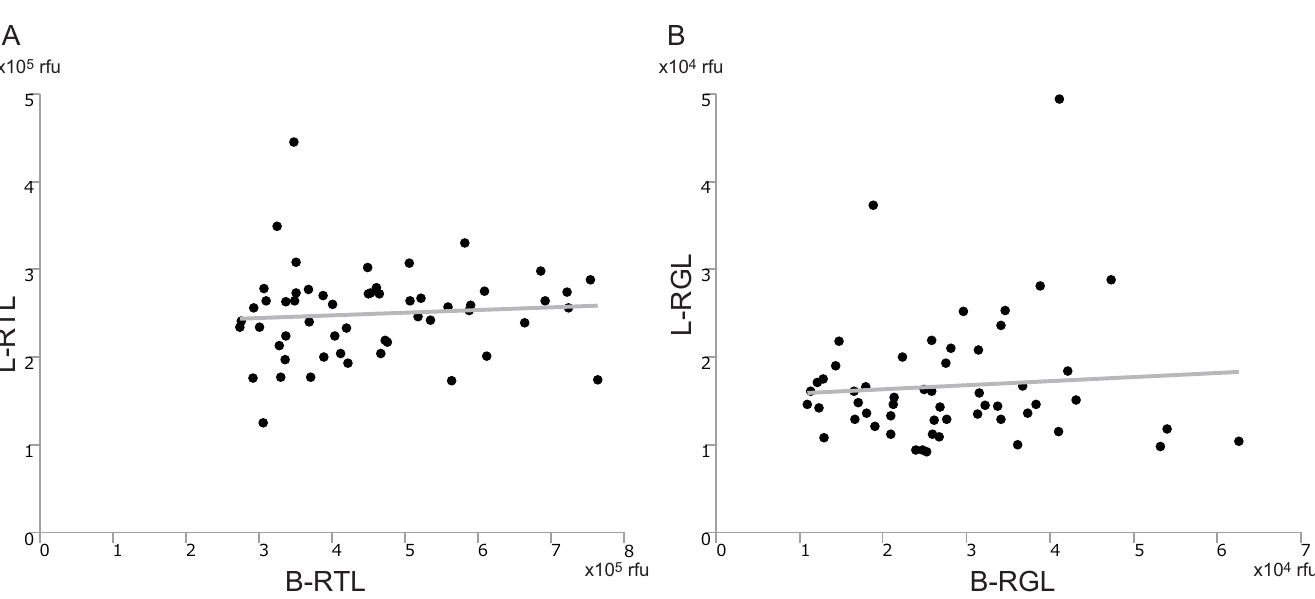
Fig 2. Correlation between telomere/G-tail length from blood and liver. (A) Correlation between B-RTL and L-RTL (y = 0.03 x + 2.35, r 2 = 0.007, p = 0.552). (B) Correlation between B-RGL and L-RGL (y = 0.05 x + 1.54, r 2 = 0.006, p = 0.583). B-RTL; relative telomere length from blood, L-RTL; relative telomere length from liver, B-RGL; relative G-tail length from blood, L-RGL; relative G-tail length from liver.